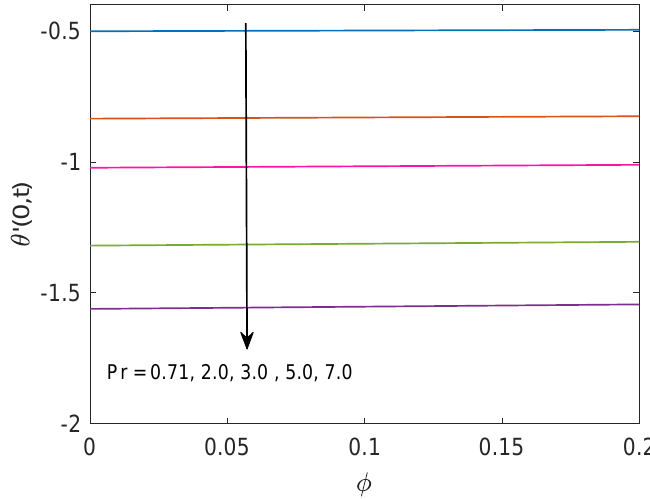
Figure 18. Profile of heat transfer rate for different Pr when Nr = 1.5, Q = 0.5 and t =